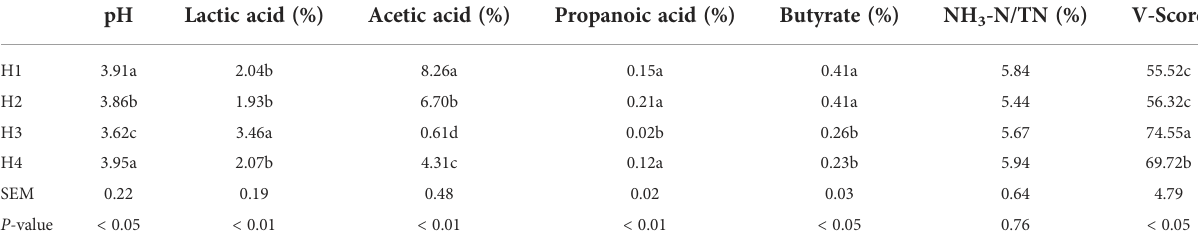
TABLE 2 Dynamics of different height Pennisetum sinese silage fermentation characteristics